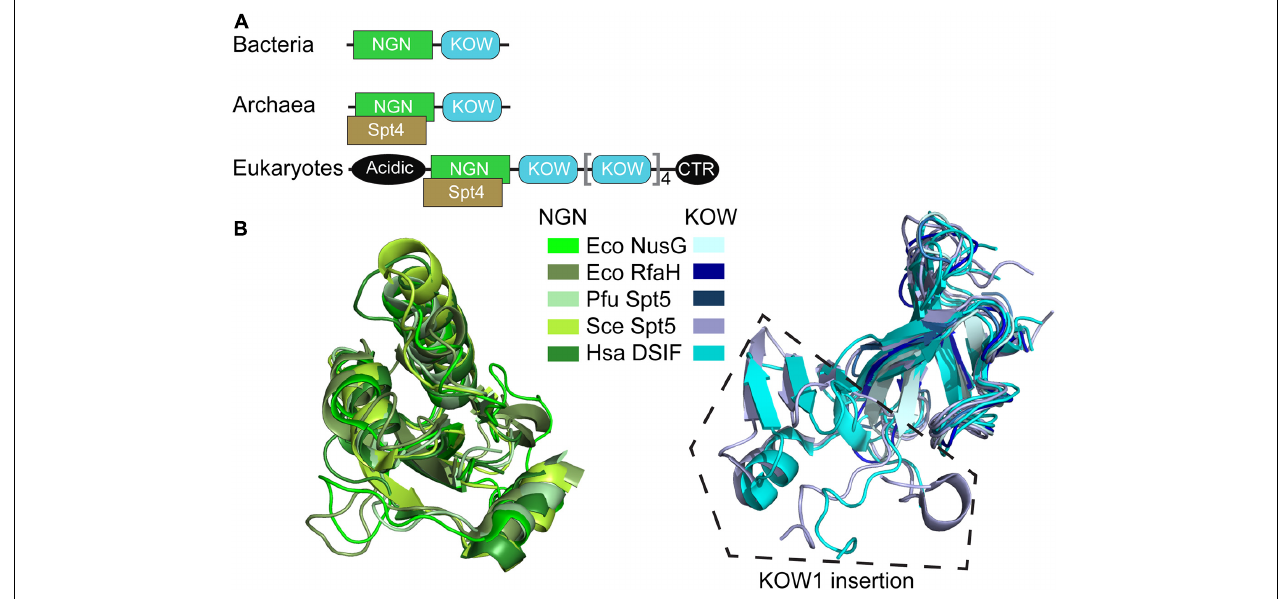
FIGURE 2 | Structural conservation of NusG-like proteins. (A) Domain organization. (B) Superposition of NGN and KOW domains. PDB IDs: E. coli (Eco) NusG-NGN: 2K06; Eco NusG-KOW: 2KVQ; Eco RfaH-NGN: 2OUG; Eco RfaH-KOW: 2LCL; Pyrococcus furiosus (Pfu) Spt5-NGN/KOW: 3P8B; Saccharomyces cerevisiae (Sce) Spt5-NGN: 2EXU; Sce Spt5-KOW1: 4YTK; Sce Spt5-KOW2/3: 4YTL; Homo sapiens (Hsa) DSIF-NGN: 3H7H; Hsa DSIF-KOW1: 5OIK; Hsa DSIF-KOW2: 2E6Z; Hsa DSIF-KOW3: 2DO3; Hsa DSIF-KOW4: 5OHO; Hsa DSIF-KOW5: 2E70. Sce Spt5-KOW1/2/3 have similar structures and are shown in the same color, as are Hsa DSIF-KOW1/2/3/4/5